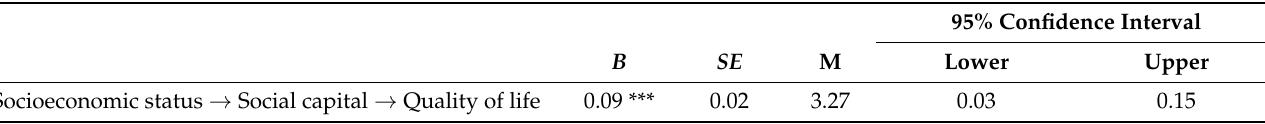
Table 6. Indirect effect of Socioeconomic status on Quality of life through Social